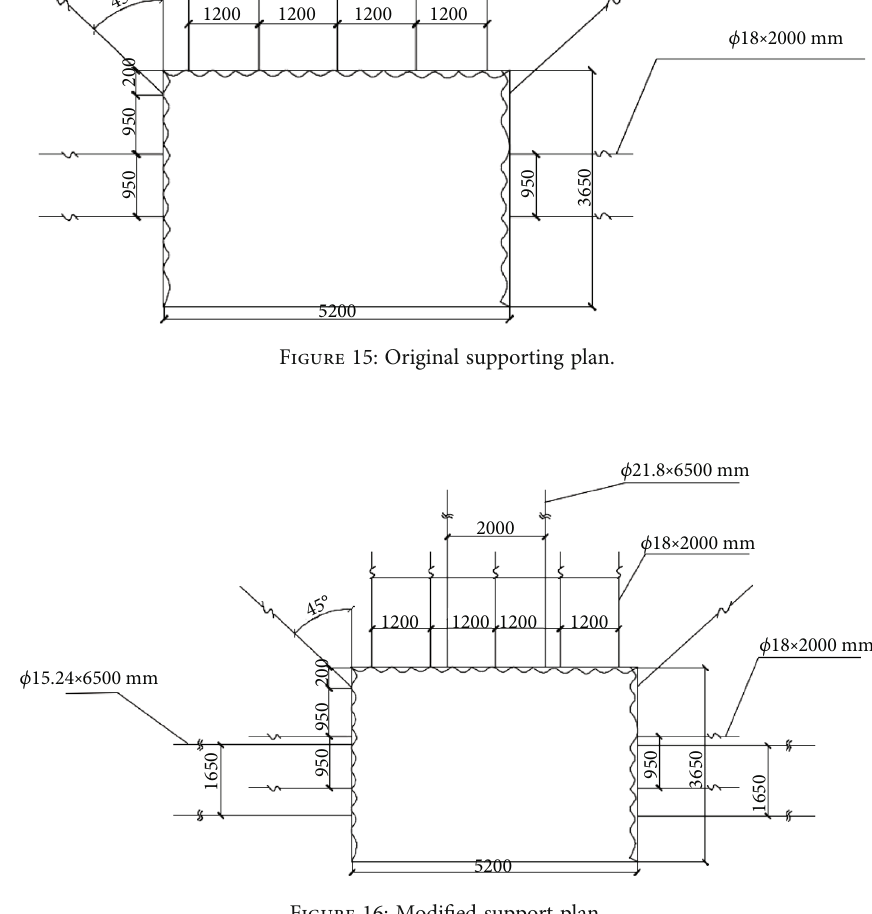
Figure 16: Modi fi ed support